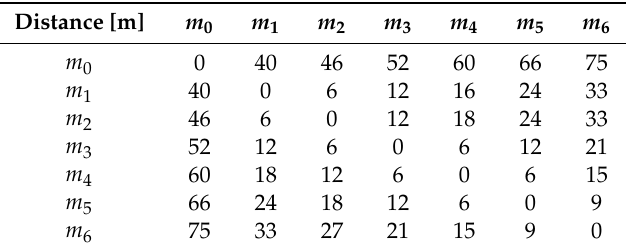
Table 2. The distance among the warehouse and machines. ( m 0 is warehouse, m 1 ∼ m 6 are machines). Distance [m]